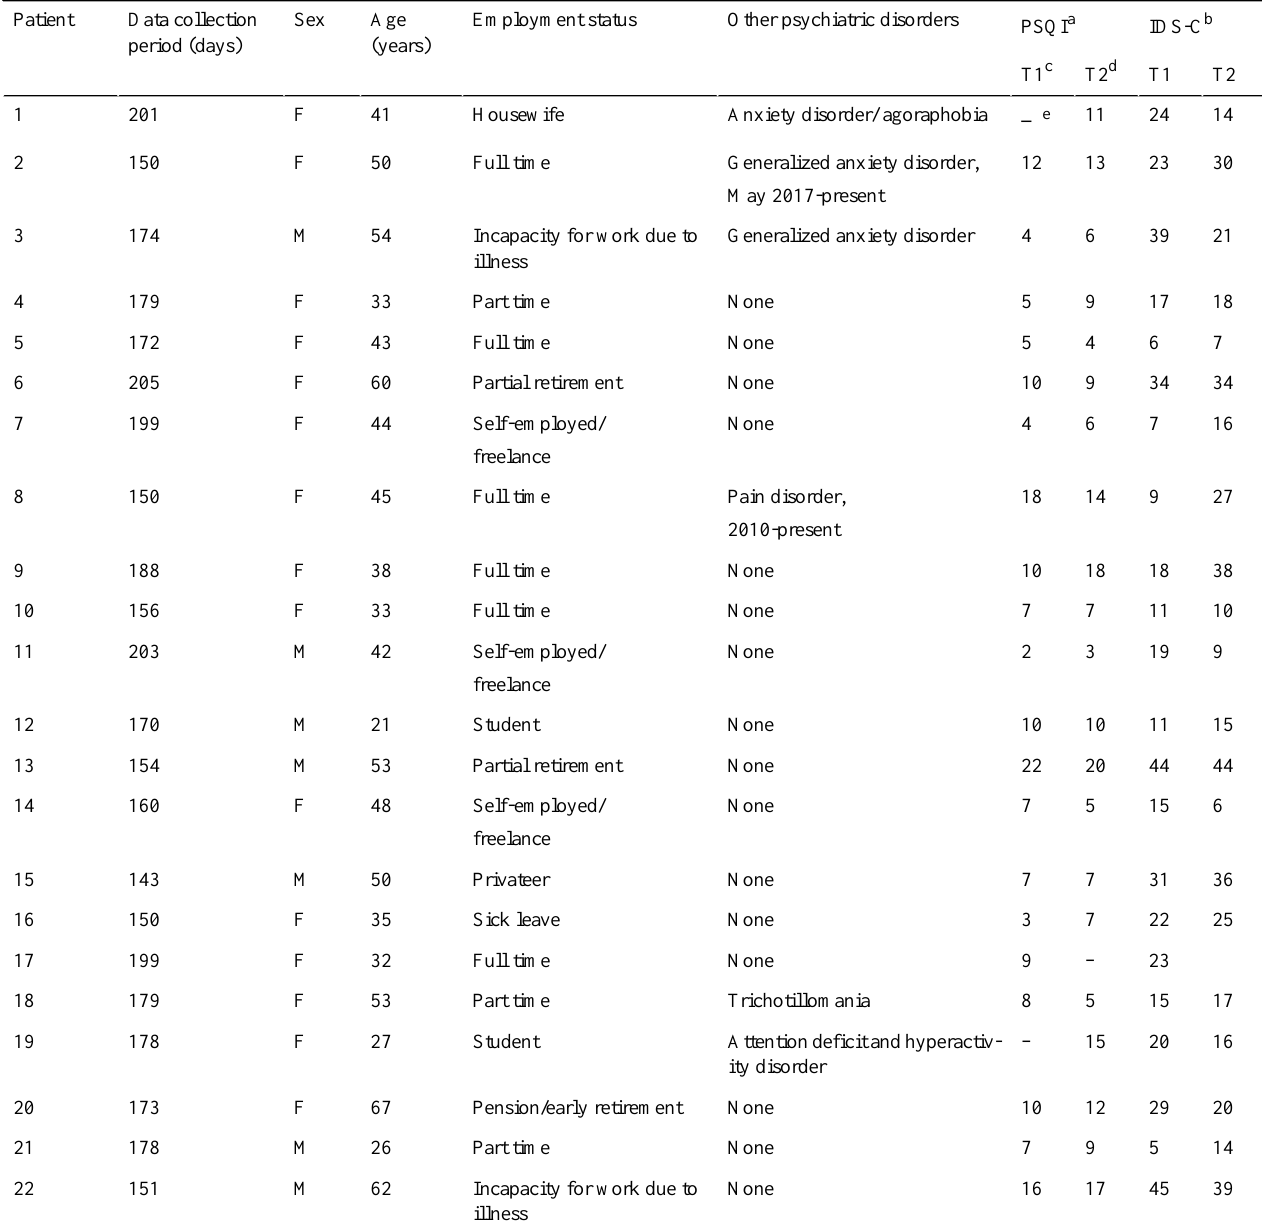
Table 1. Demographic and clinical